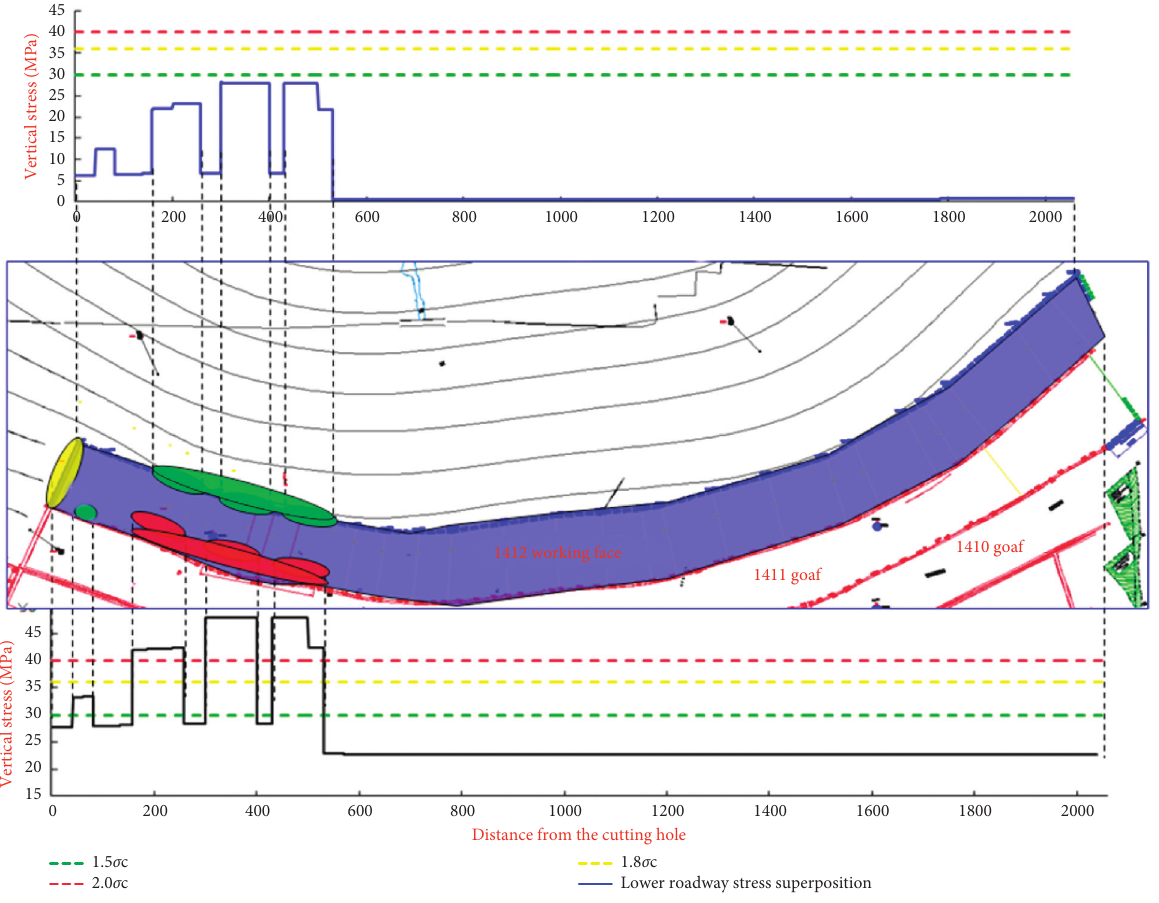
Figure 8: Layout of No. 1412 working face.